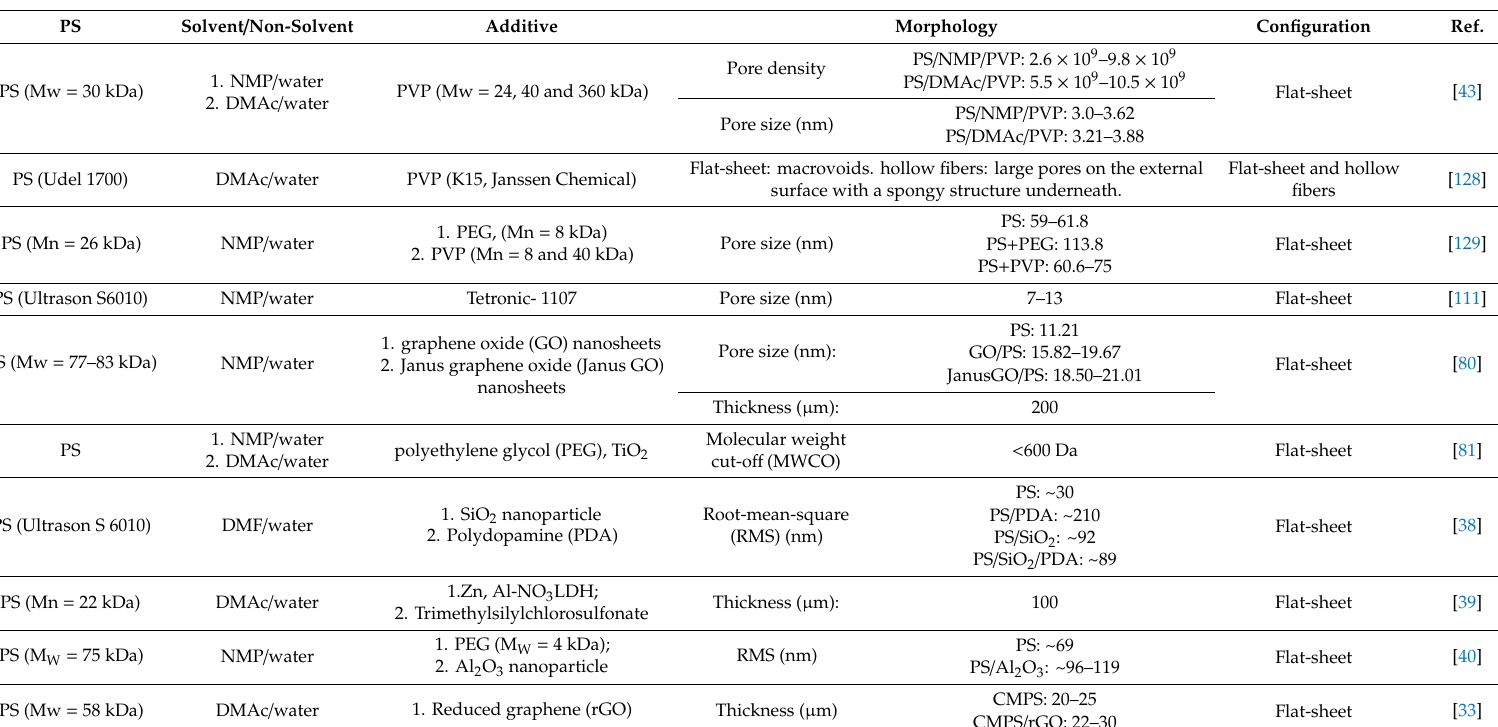
Table 4. Typical additives used for PS membrane fabrication with their